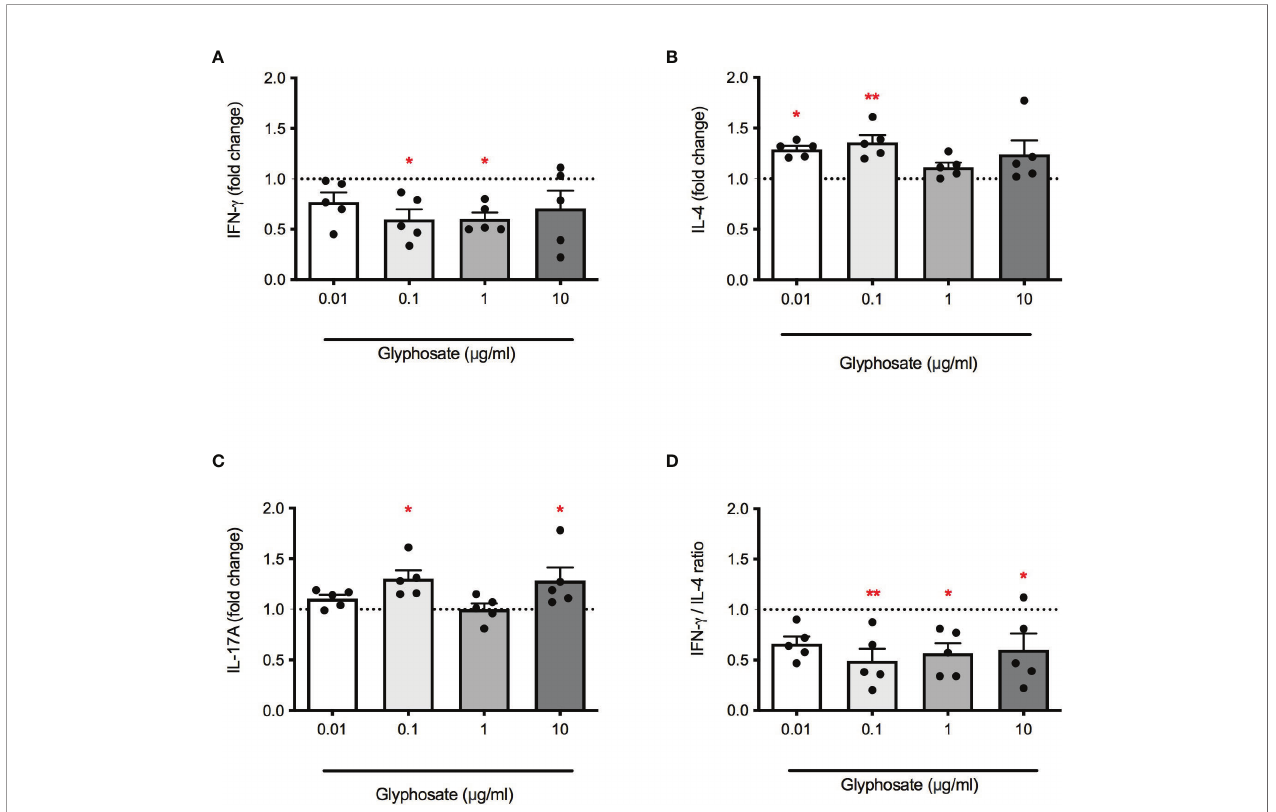
FIGURE 2 | Effect of G on PMA plus ionomycin-induced IFN- g , IL-4 and IL-17A release. PBMC (10 6 /mL) were treated for 1 h with increasing concentrations of G (0.01, 0.1, 1 and 10 µg/mL), and then stimulated with PMA and ionomycin for 72 h. Cytokines were measured by ELISA in cell-free supernatants. (A) IFN- g release. (B) IL-4 release. (C) IL-17A release. (D) IFN- g /IL-4 ratio. Results are expressed as fold-change of the released cytokines in G treated cells compared to control cells. The dotted line reported is set at 1.0 (control). Each value represents the mean ± SEM, n = 5 donors. Each dot represents the value of the single individual. Statistical analysis was performed with Dunnett ’ s multiple comparison test, with * p < 0.05 and **p < 0.01 vs control